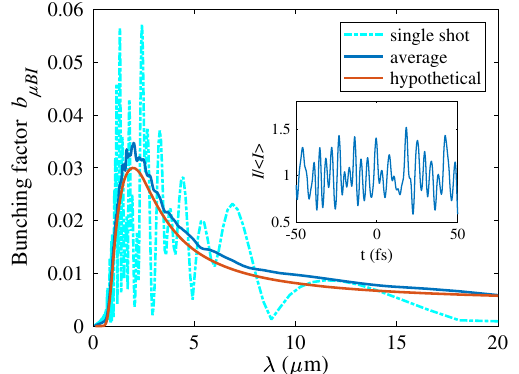
FIG. 3. The average spectra over 500 shots of self-seeding and SASE with or without μ BI at the same undulator position 0 . 03 . z ¼ 48 m. The inserted figure shows the fractional spectral BI ¼ energy as a function of integration bandwidth. The peak ampli- tude of the hypothetical bunching spectrum b μ